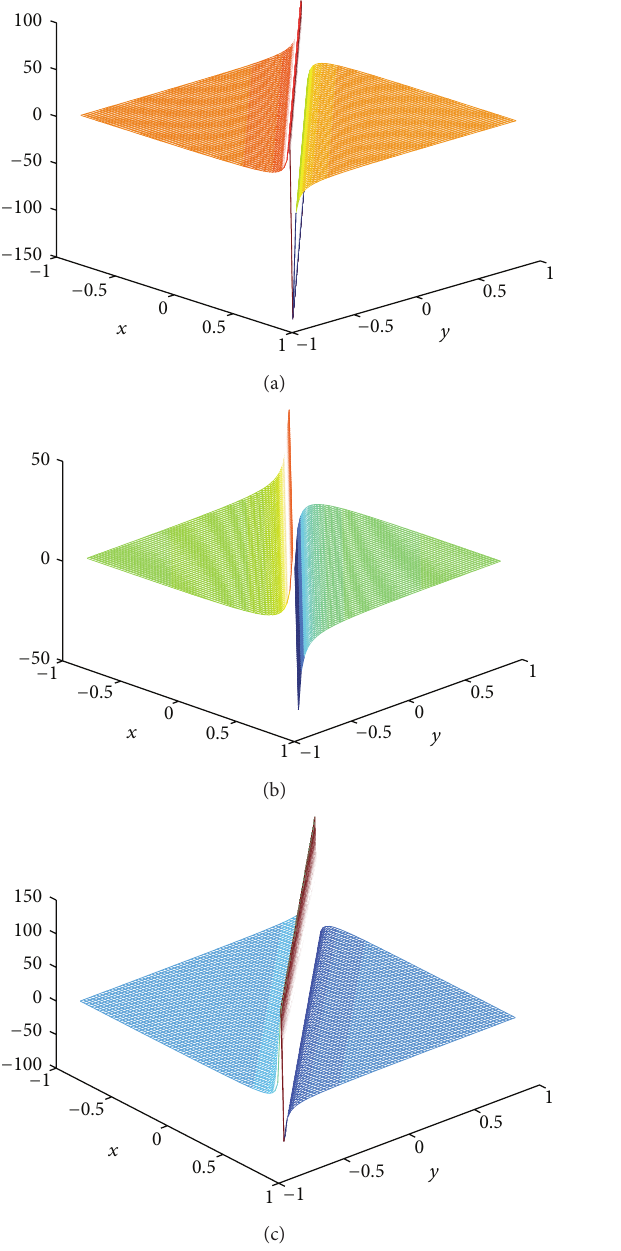
Figure 5: The solution of BLP corresponding to 𝑢 𝑠,5 : take 𝑐 = 1 , = 0 ; (a) 𝑡 = −1/125 , (b) 𝑡 = 1/10000 , and (c) 𝑡 = 1/125 𝛼 = 1 , 𝑧 0